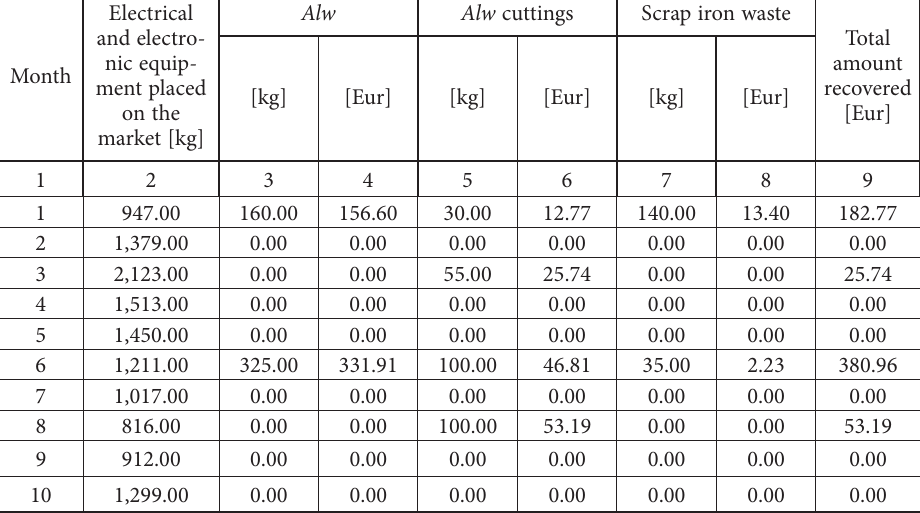
Table 5. Waste situation and amounts